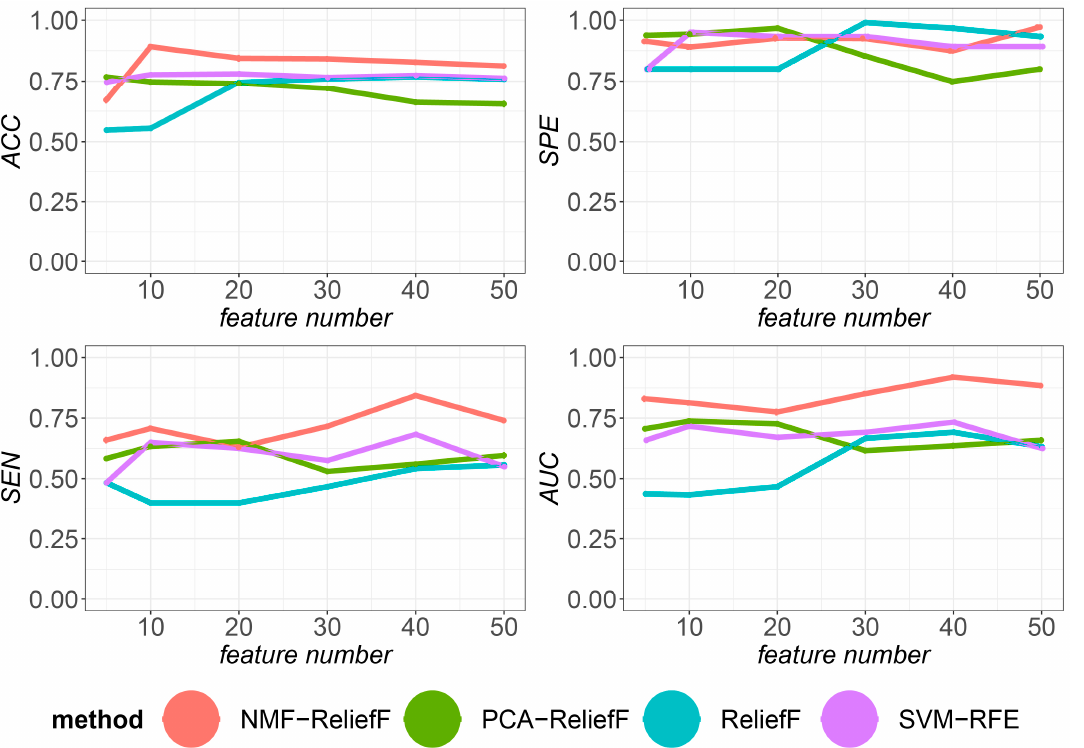
Figure 5. Evaluation index values for different algorithms at feature counts of 5, 10, 20, 30, 40, and 50, respectively. The four algorithms differed in accuracy, sensitivity, specificity, and AUC on the insect gene family data set.